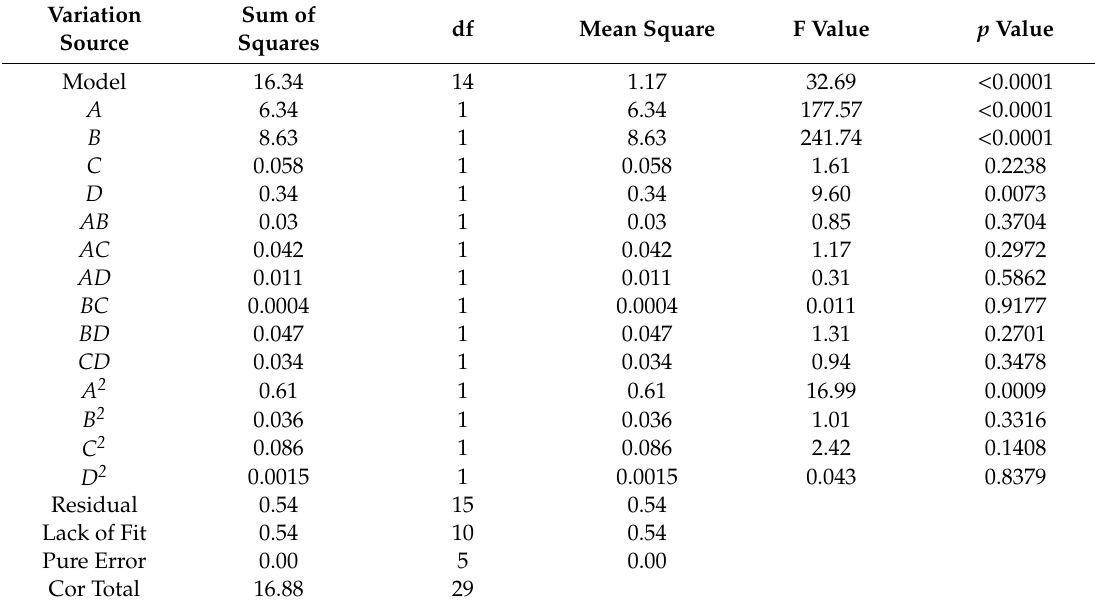
Table 8. Analysis of variance for cost regression